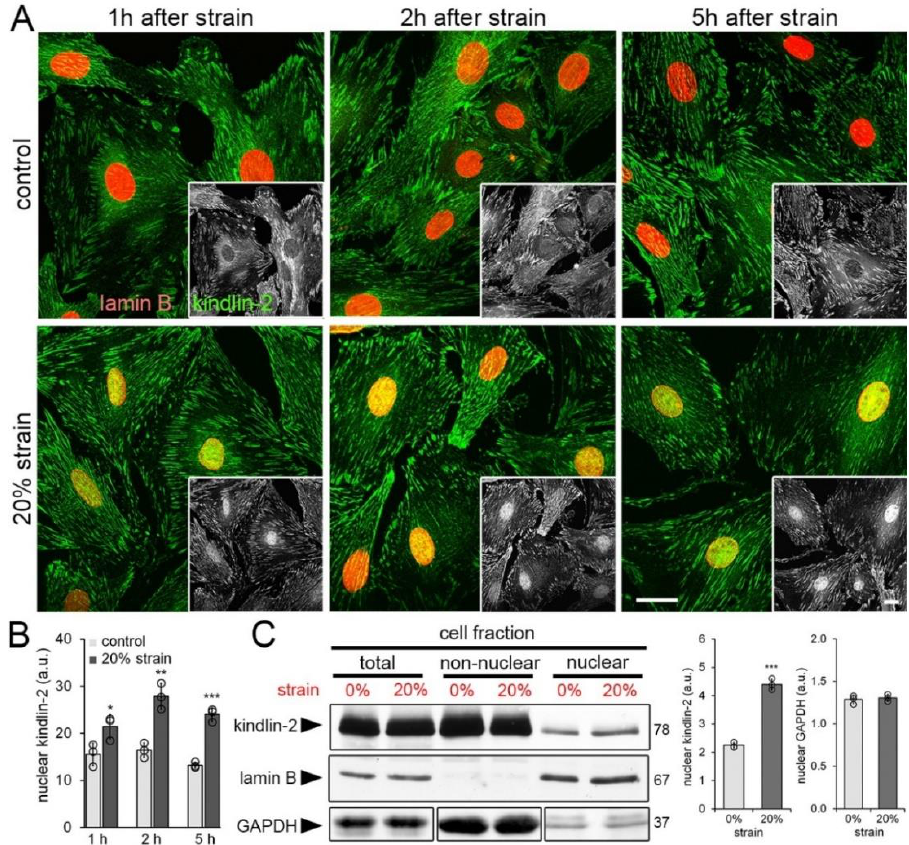
Figure 3. Cell straining leads to kindlin-2 accumulation in the nucleus. Human cardiac fibroblasts (hCF) were strained on silicone culture membranes once by 20% and assessed after di ff erent times. ( A ) 1 h, 2 h, and 5 h after unique cell strain (20% strain) or non-strained (control), hCF were immunostained for kindlin-2 (green) and lamin B (red) and scanning confocal images were taken; greyscale insets show kindlin-2. Scale bars: 15 µ m. ( B ) Levels of kindlin-2 in the nucleus (fluorescence intensity) were quantified by image analysis from confocal images. ( C ) Nuclear, non-nuclear, and total cell fractions were isolated and analyzed by immunoblotting and densitometry. Lamin B expression levels were used as a loading control for nuclear and total fractions; Glyceraldehyde 3-phosphate dehydrogenase (GAPDH) was used to control similar loading of the non-nuclear and total fractions. Total fractions were diluted 1:2 to allow simultaneous blotting of all fractions without signal saturation. Shown are mean values from at least three independent experiments (data points) ± SD (* p < 0.05, ** p < 0.01, *** p < 0.005, using ANOVA followed by a post-hoc Tukey’s multiple comparison test).